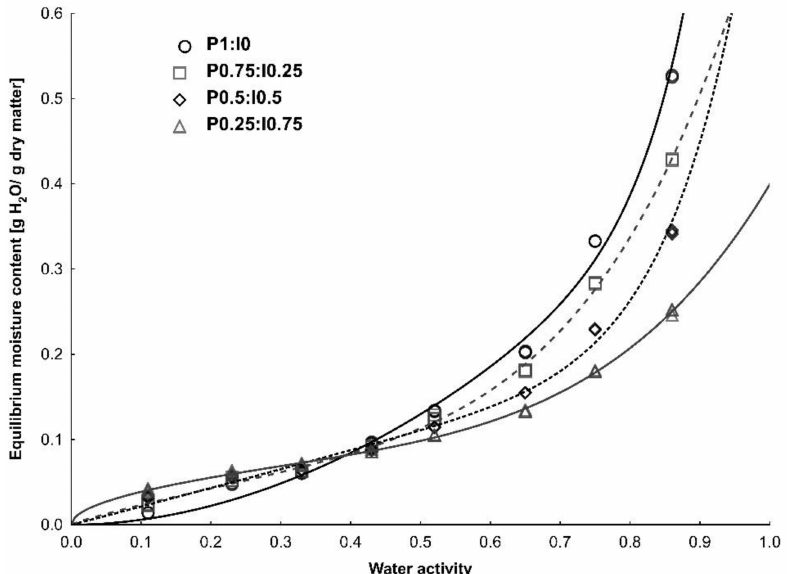
Figure 1. Adsorption isotherms of freeze dried pumpkin powder produced with different inulin additions fitted by the Peleg